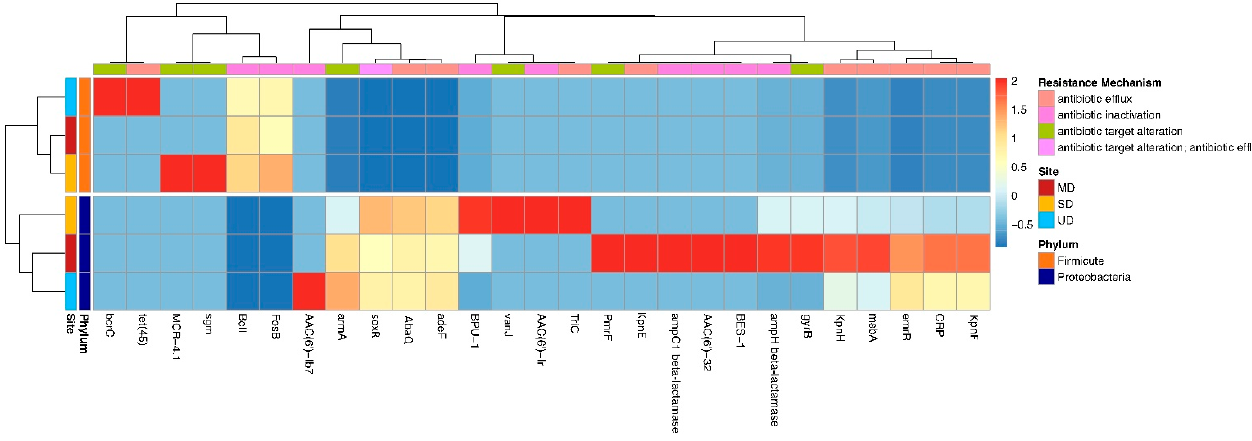
Figure 4. The proportion of ( a ) Bacillus and ( b ) Pseudomonas isolates from each FPES site that contain each ARG.